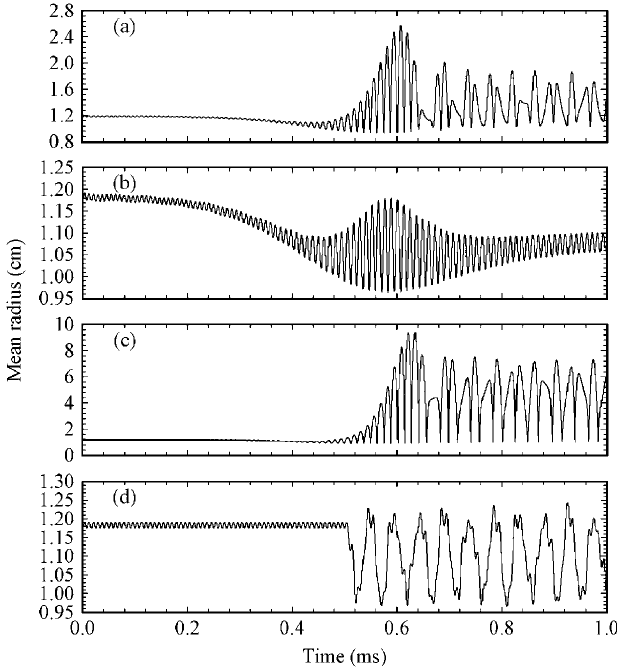
p FIG. 12. The evolution of the mean radius (cid:1)(cid:1)(cid:1)(cid:1)(cid:1)(cid:1) ab is plotted for four different values of the transition time scale (cid:9) . (a) When (cid:9) (cid:3) (cid:9) , the mean radius undergoes large-amplitude oscillations and c ( 26 f (cid:1) 1 the final beam is not well matched. (b) When (cid:9) (cid:12) (cid:9) c 0 here), the charge bunch is able to follow the changing transverse focusing frequency and the final state is well matched. (c) As (cid:9) is , the mean radius grows to the wall decreased further from (cid:9) c (cid:3) 10 cm . (d) Instantaneous changes compress the radius r w plasma, but leave large residual oscillations of the mean